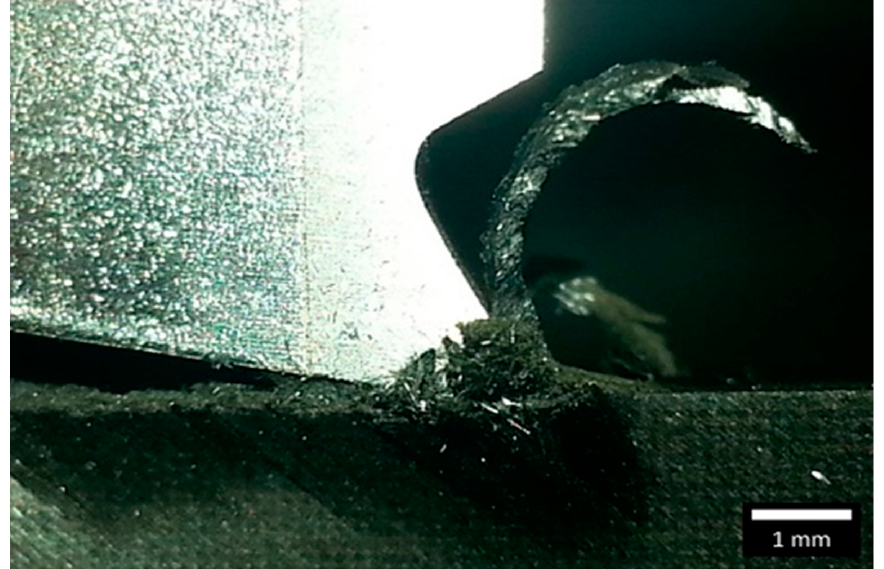
Figure 6. Chip formation for experiment 34 at fibre orientation of 135°, rake angle of 30°, and depth of cut of 150 µm. (The white scale bar = 1 mm).